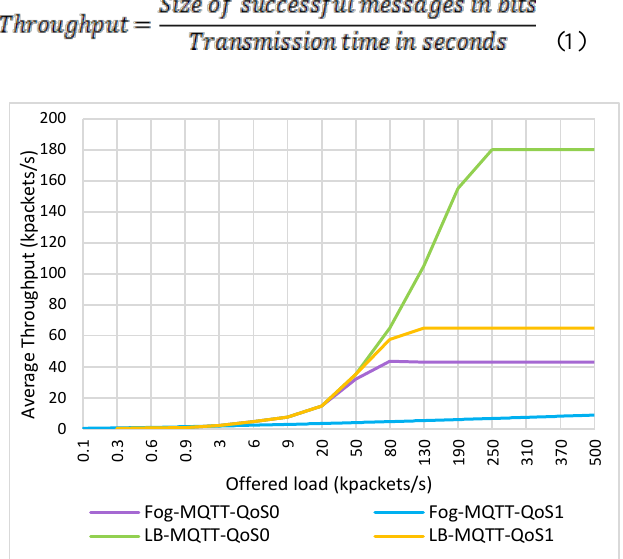
Figure 12. Average throughput of IoT-F2CDM-LB architectures